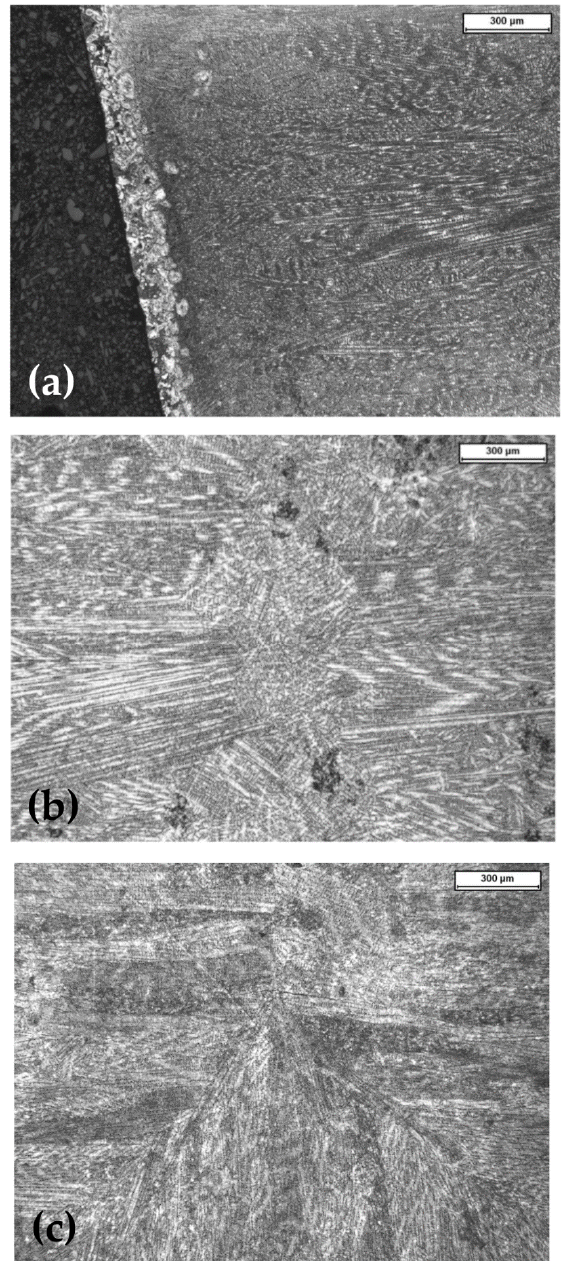
Figure 7. Optical micrograph of the microstructure of samples obtained through ESF on the YZ plane. ( a ) edge of sample B, ( b ) core of sample B, ( c ) core of sample G.